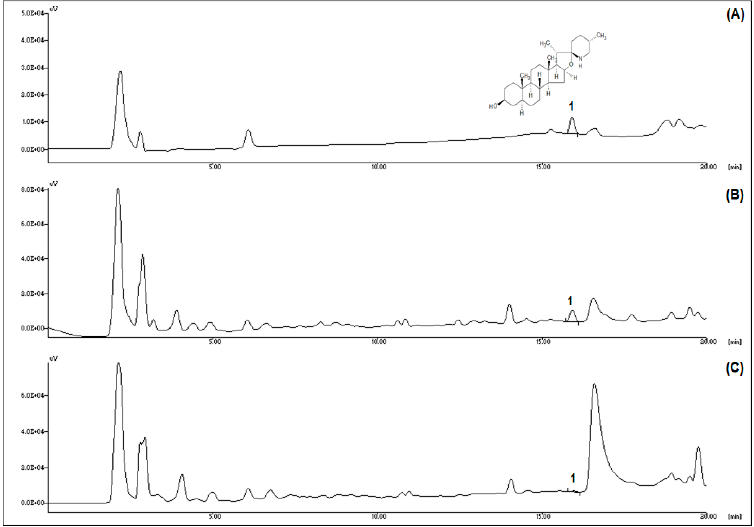
Figure 1. Tomatidine profiles of green and red tomatoes. ( A ) Chromatogram of typical tomatidine. ( B ) Chromatogram of green tomatoes. ( C ) Chromatogram of red tomatoes. Peak identification: 1, tomatidine. Table 2. Tomatidine contents of tomato fruits.